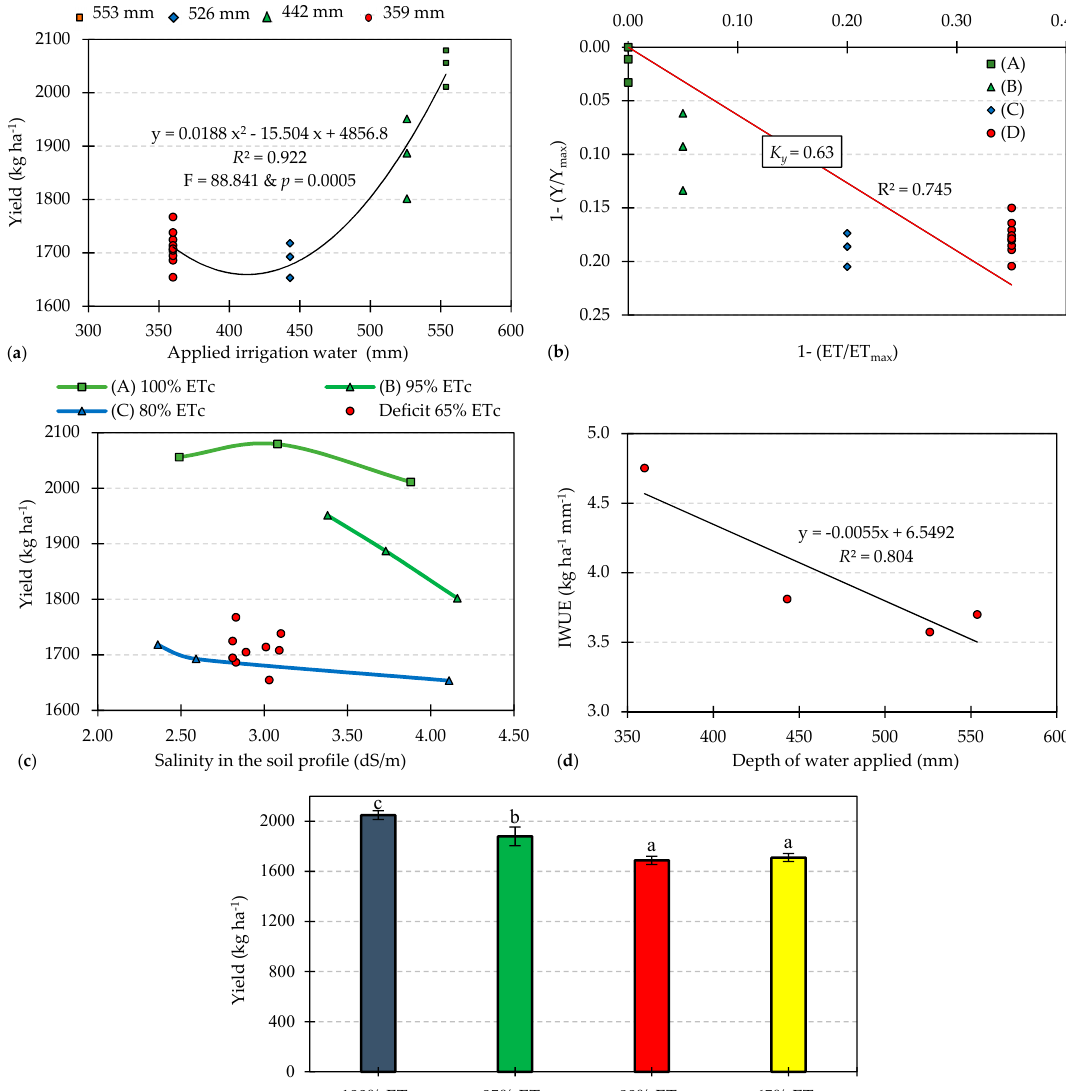
Figure 11. ( a ) Relationship between yield (kg·ha − 1 ) and applied irrigation water and the production function. ( b ) Relationship between yield and evapotranspiration, along with the response factor. ( c ) Relationship between the added salinity in the soil profile (dS·m − 1 ) and yield (kg·ha − 1 ) for the four irrigation treatments. ( d ) Relationship between water use efficiencies and the applied depth of water (mm). ( e ) Yield as a function of the percentage of ET C applied; error bars denote means ± SD of the replicates. Bars with different letter denote significance in treatments at p < 0.05; analyzed by Tukey post-hoc test.